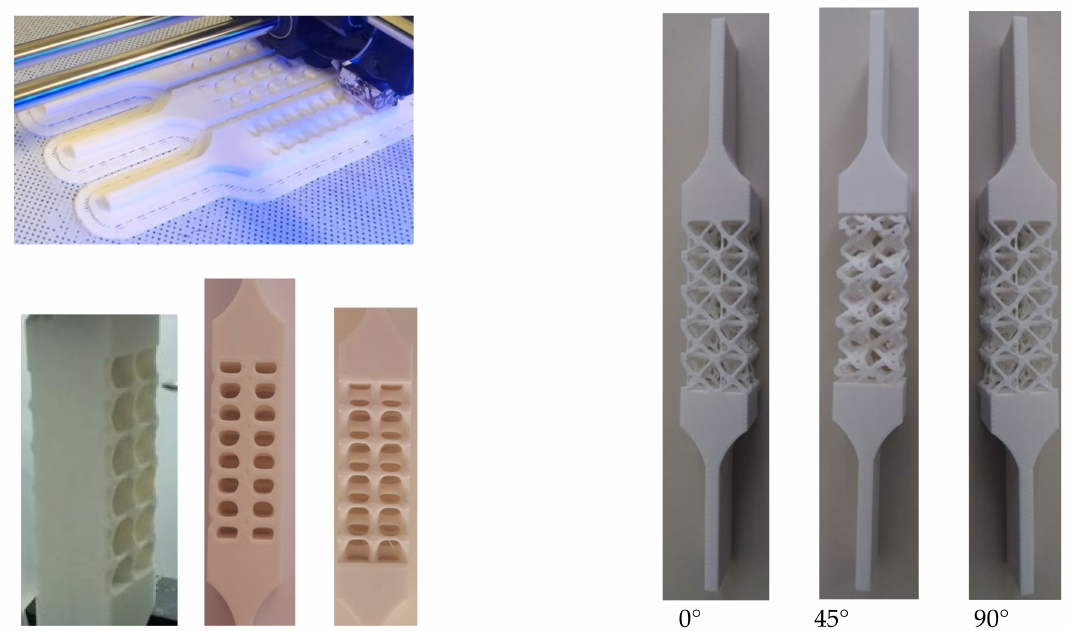
Figure 11. Preparation and printing of the tensile strength samples with 0 ◦ , 45 ◦ and 90 ◦